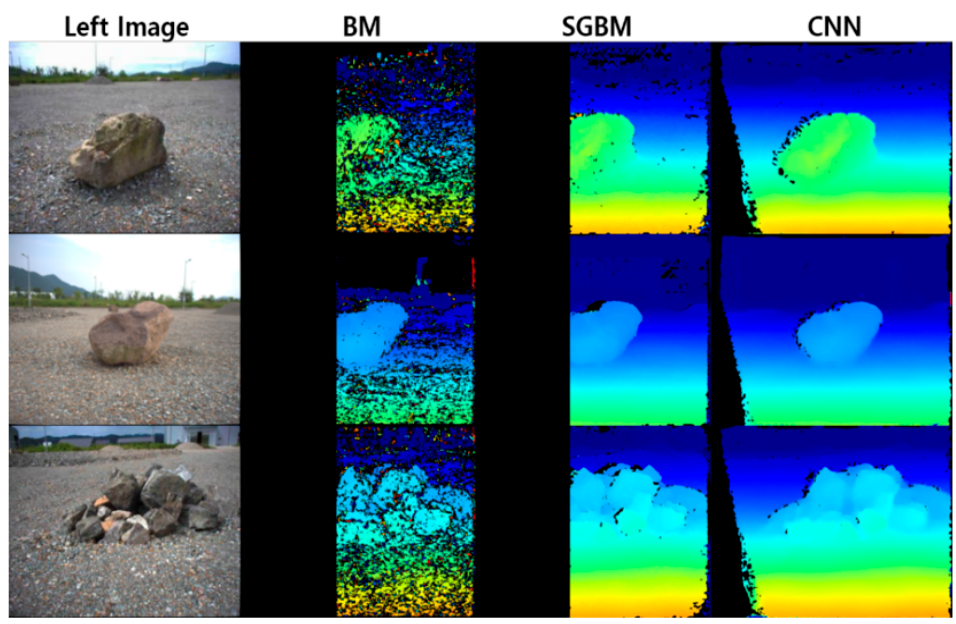
Figure 6. Comparison of dense disparity map.